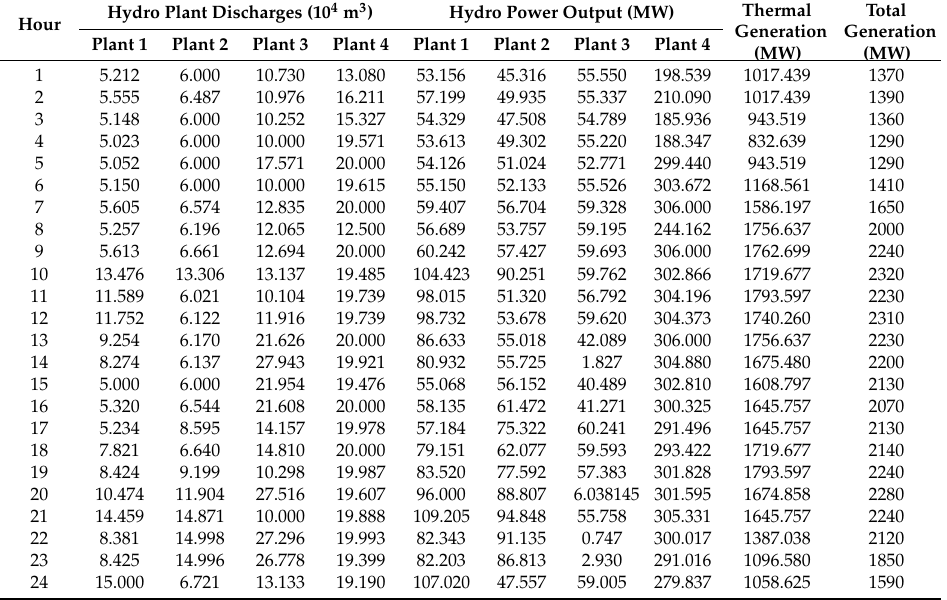
Table 3. Hourly plant discharges, power outputs and total thermal generation (test system 1, case 2). Hydro Plant Discharges (10 4 m 3 ) Hydro Power Output Hour